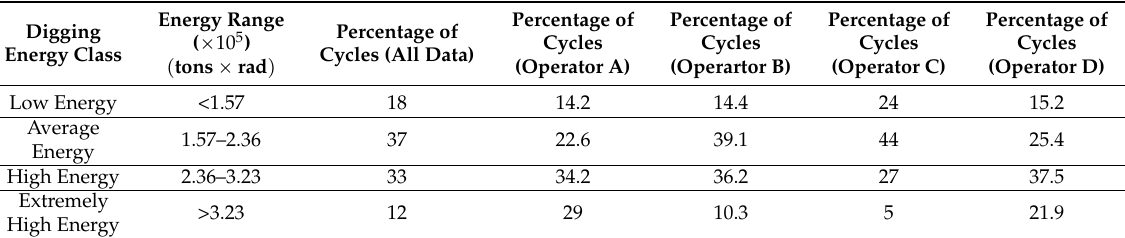
Table 2. Digging energy classification.